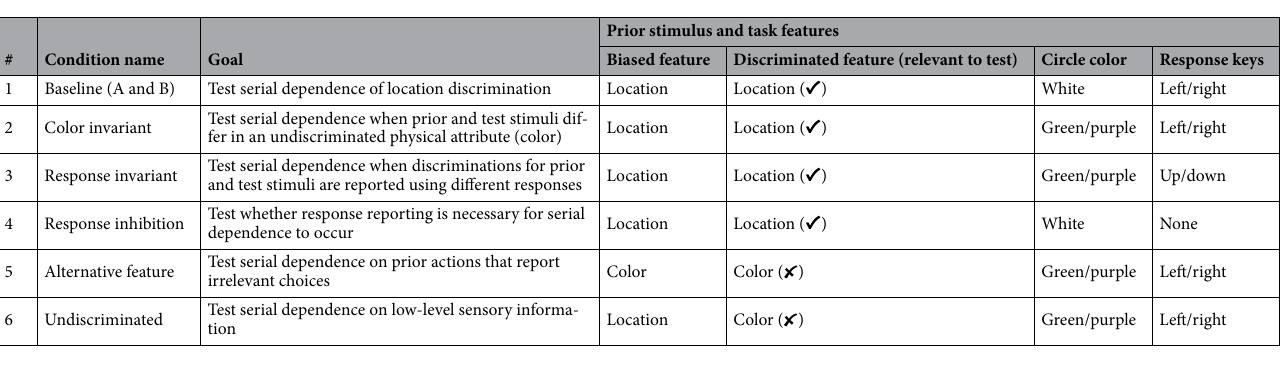
Table 1. Experimental conditions. ✔ Indicates that the priors task was relevant to the test task (both were location discrimination). ✘ Indicates that the priors task (color discrimination) was irrelevant to the test task (location